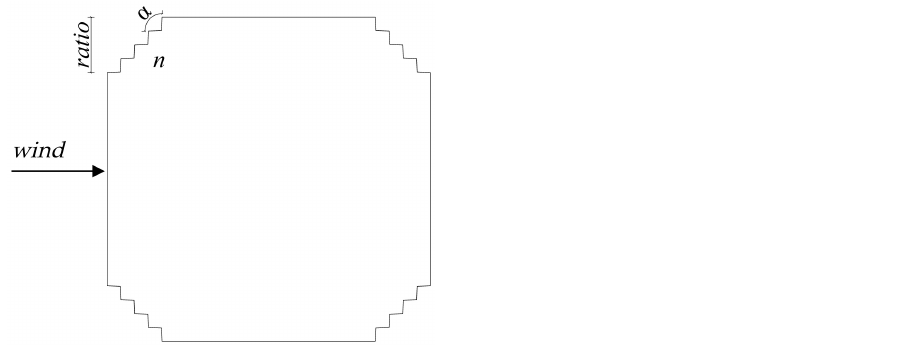
Figure 1. Schematic diagram of the geometric parameters of the 2D square cylinder with corner recession.